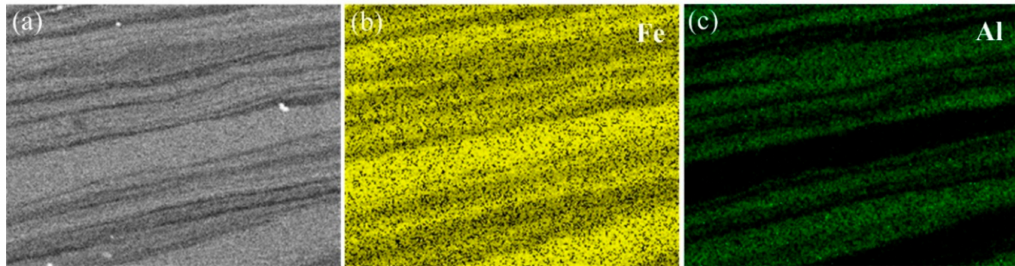
Figure 12. Chemical maps of the layered structure. ( a ) The composite map showing initial structure; ( b ) element Fe; and ( c ) element